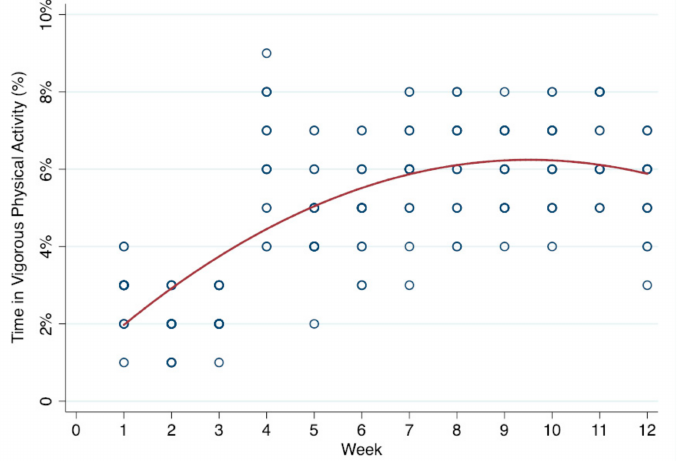
Figure 2. Quadratic time trend in vigorous physical activity (%) across weeks.